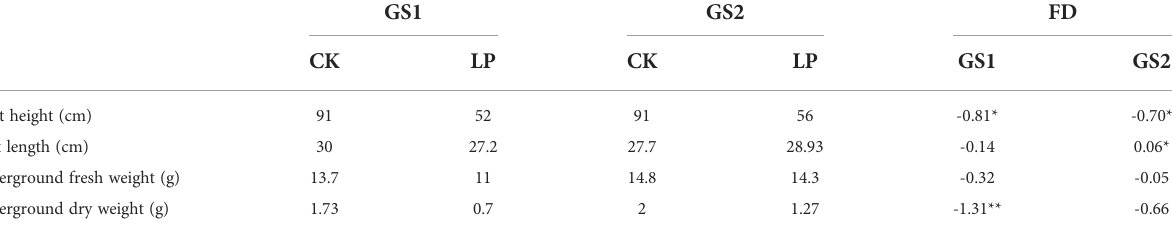
TABLE 1 Effects of LP stress on growth parameters of two ecotypes of wild soybean seedlings.